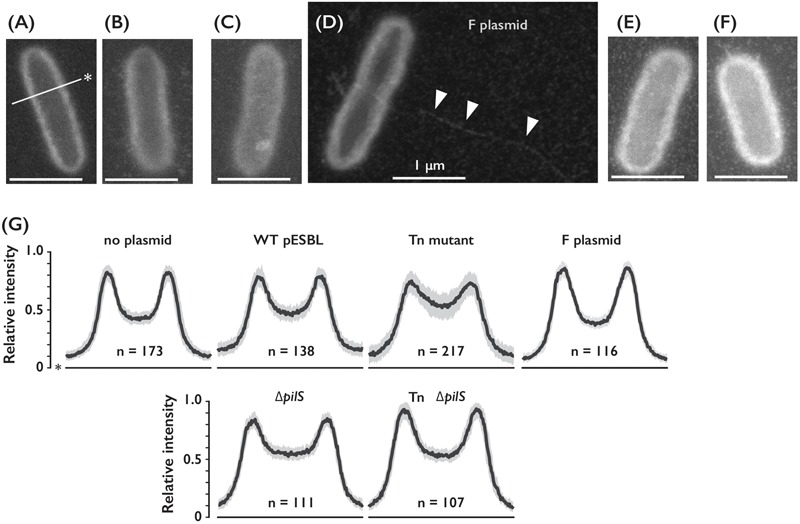
Cell surfaces of E. coli cells harboring different conjugative plasmids. (A–D) Representative ASEM images of E. coli cells without plasmid (A), or harboring either WT (B), Tn (C)
ΔpilS
(E) or Tn ΔpilS mutant (F) of pESBL, and F plasmid (D). Arrowheads indicate presumable F pilus. Line with an asterisk indicates perpendicular axis for the intensity profile analysis. Bar = 1 μm. (G) Intensity profile of E. coli cells with or without plasmids as indicated. Among number of cells analyzed shown as n, median was drawn by the solid line and the gray area represents between the first and third quartiles.